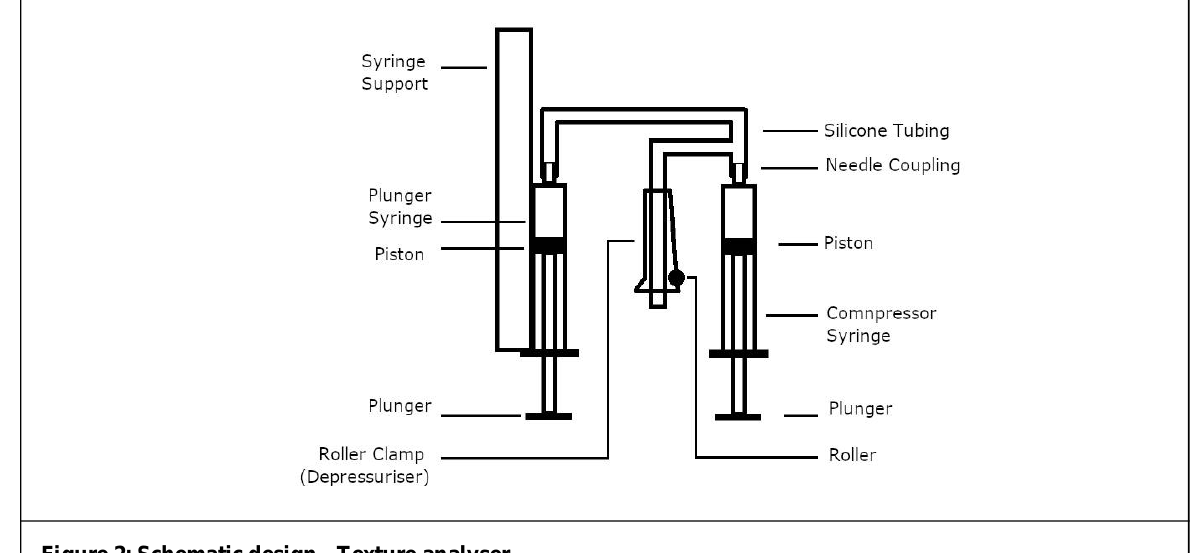
Figure 2: Schematic design - Texture analyser